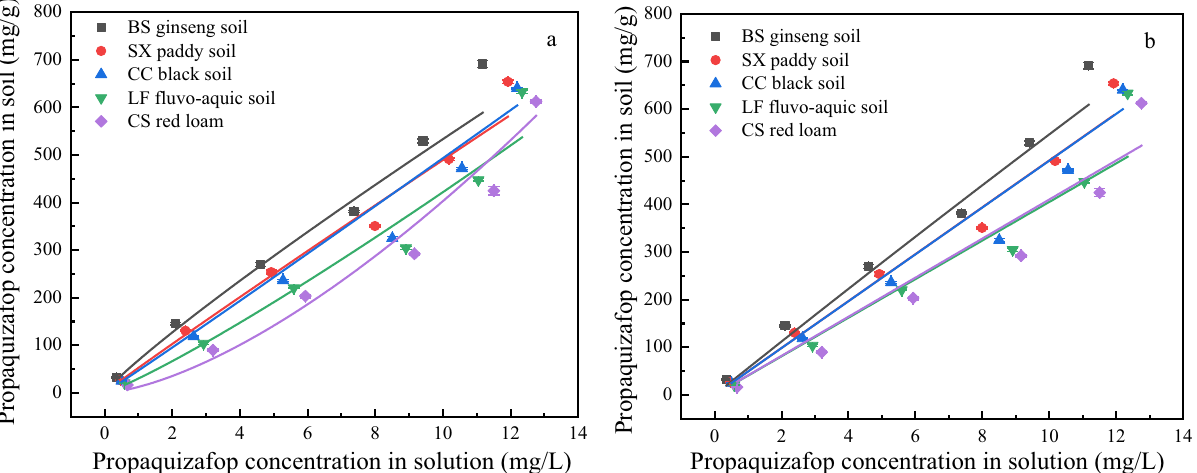
Figure 3. ( a ) Freundlich and ( b ) Langmuir modes isotherms of propaquizafop in five different agricultural soils (n = 3).